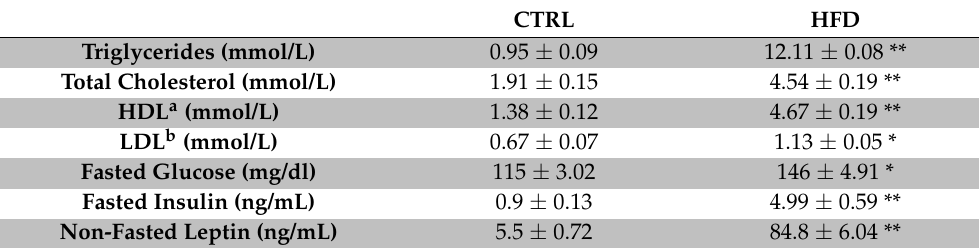
Table 2. Blood levels of glucose, lipids, and hormones related to HFD phenotype. Data are expressed relative to the CTRL group and reported as mean ± SEM; * p < 0.05; ** p < 0.01. CTRL HFD Triglycerides (mmol/L) 0.95 ± 0.09 12.11 ± 0.08 ** Total Cholesterol (mmol/L) 1.91 ± 0.15 4.54 ± 0.19 ** HDL a (mmol/L) 1.38 ± 0.12 4.67 ± 0.19 ** LDL b (mmol/L) 0.67 ± 0.07 1.13 ± 0.05 * Fasted Glucose (mg/dl) 115 ± 3.02 146 ± 4.91 * Fasted Insulin (ng/mL) 0.9 ± 0.13 4.99 ± 0.59 ** Non-Fasted Leptin (ng/mL) 5.5 ± 0.72 84.8 ± 6.04